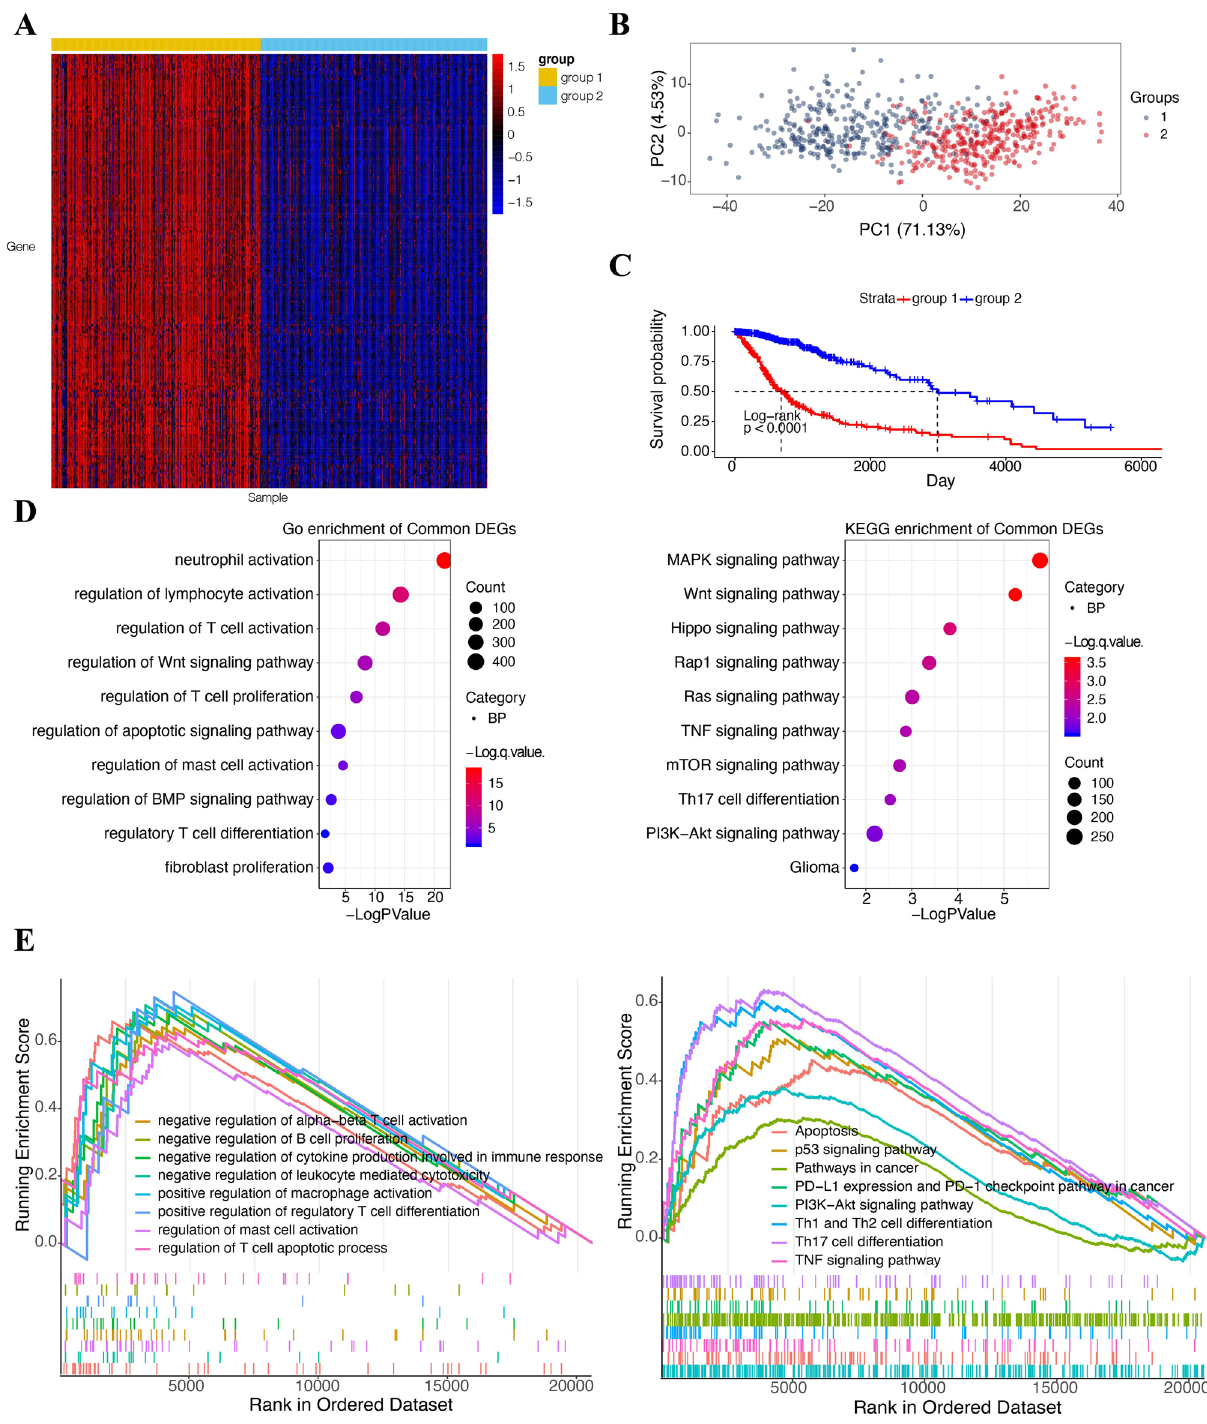
Figure 6. Classification of glioma patients and characteristics of each subtypes in TCGA cohort. ( A ) Heatmaps illustrate the condition of classification. Each column represents the glioma sample and each row represents the B2M-related gene. Expression values of B2M-related genes are z-transformed and are colored red for high expression and blue for low expression, as indicated in the scale bar. ( B ) Principal component analysis (PCA) shows the consequence of classification. ( C ) Kaplan–Meier analysis of OS was performed in two clusters. ( D ) GO and KEGG enrichment analysis of two clusters relevant signature genes 25–27 . ( E ) GSEA of two clusters relevant signature genes sets downloaded from the GO and KEGG database, respectively 25–27